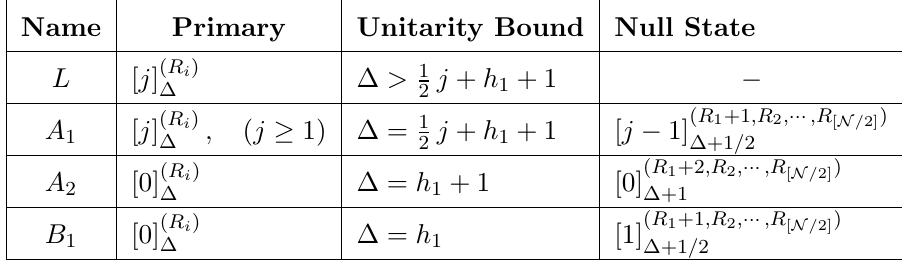
Table 29 . Unitary representations of the 3 d; N (cid:21) 3 superconformal algebra.